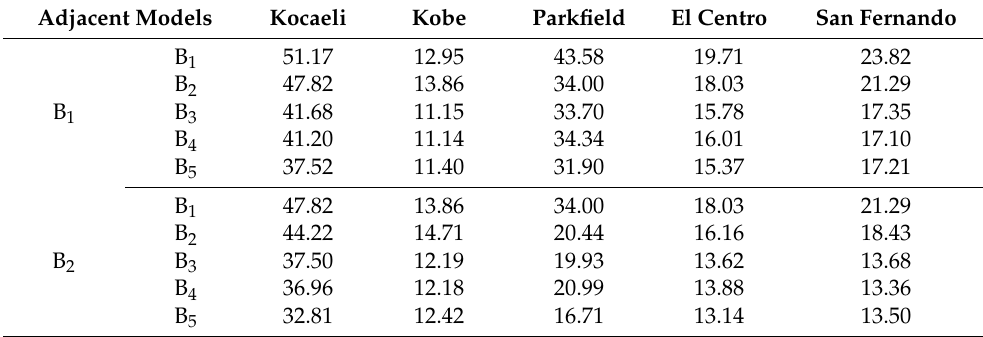
Table 4. Calculated separation distance for different models under various ground motions (cm). Adjacent